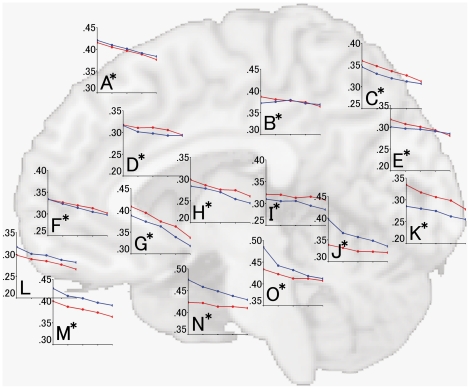
Correlations between age group and regional gray matter volumes for the medial aspect of the superior frontal gyrus (A), posterior cingulate cortex (B), precuneus (C), cingulate cortex (D), cuneus (E), anterior cingulate cortex (F), insula (G), caudate nucleus (H), thalamus (I), lingual gyrus (J), superior occipital gyrus (K), orbital gyrus (L), rectal gyrus (M), parahippocampal gyrus (N), and fusiform gyrus (O).Details are the same as in Figure 4. Each graph in each parcel is superimposed onto a brain MR image of the medial view that nearly corresponds to the anatomical location.